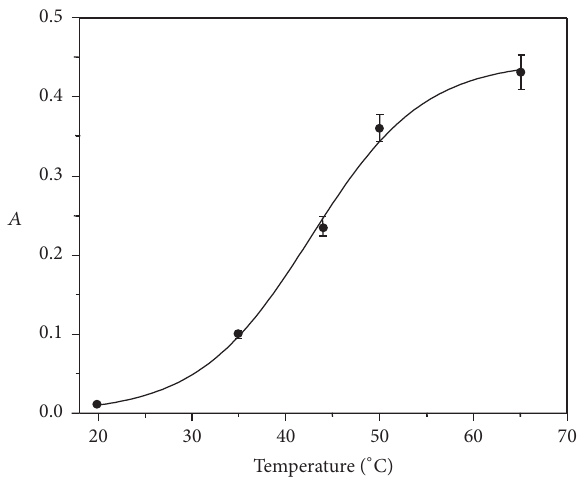
Figure 4: Concentration effect of NaOH (4.0 × 10 −4 –0.56 mol L −1 ) on the AOF-KMnO 4 system, with AOF 2.3 × 10 −5 molL −1 , KMnO 4 9.0 × 10 −4 mol L −1 , Na 2 SO 4 0.20 mol L −1 , t = 30min, T ∘ = 50 ∘ C, and monitoring at 610nm.